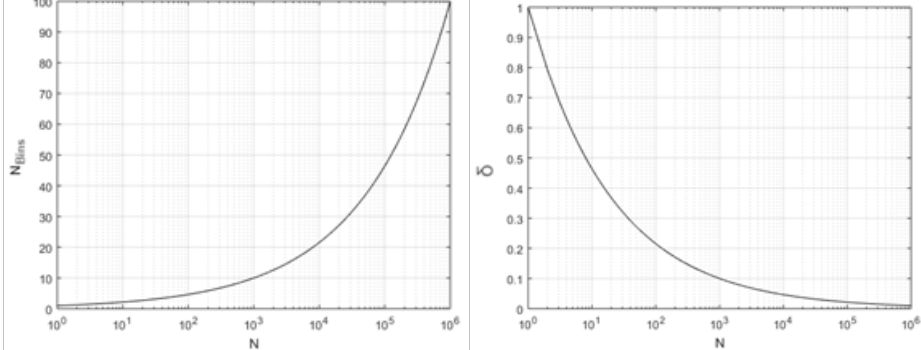
, N n N  for choosing the necessary accuracy. Bins P